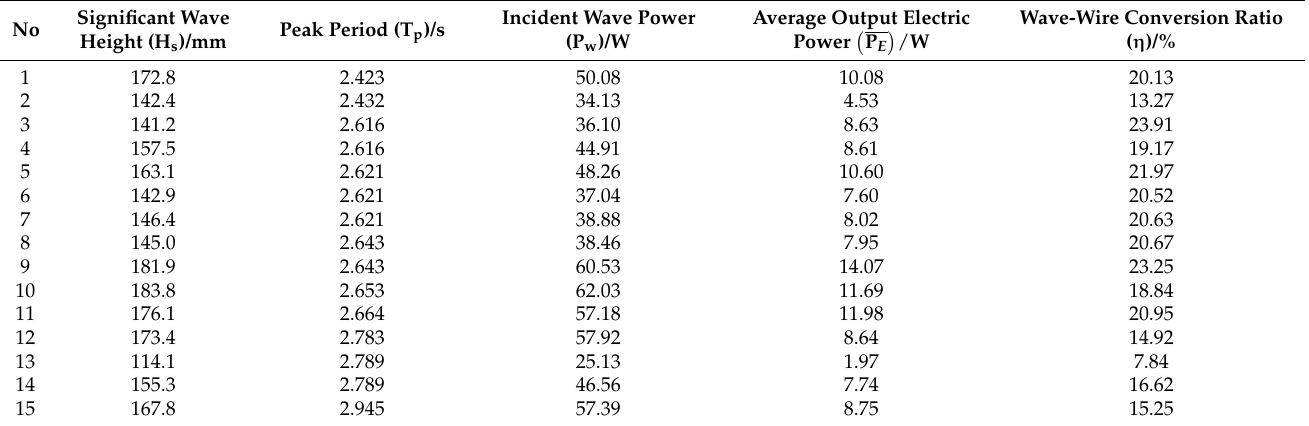
Table 5. The irregular waves test results.